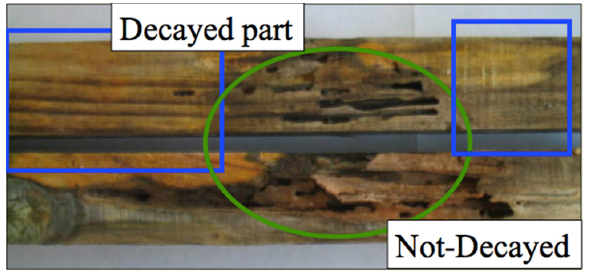
Figure 1. Picture showing the avoidance of the decayed part of the field stakes by termites ( blue boxes ) and feeding on the not-decayed parts ( green circle ).